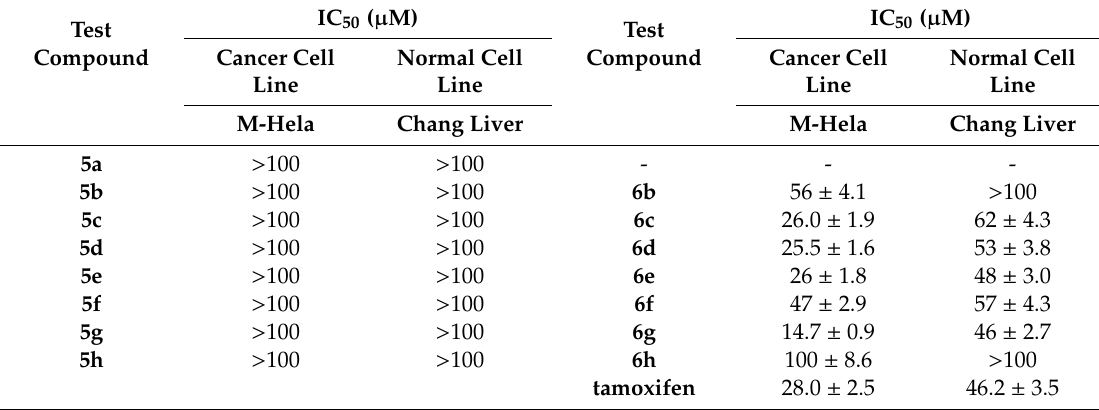
Table 2. Cytotoxic e ff ects of pyrrolidines 5a – 6h on the cancer and normal human cell lines 1